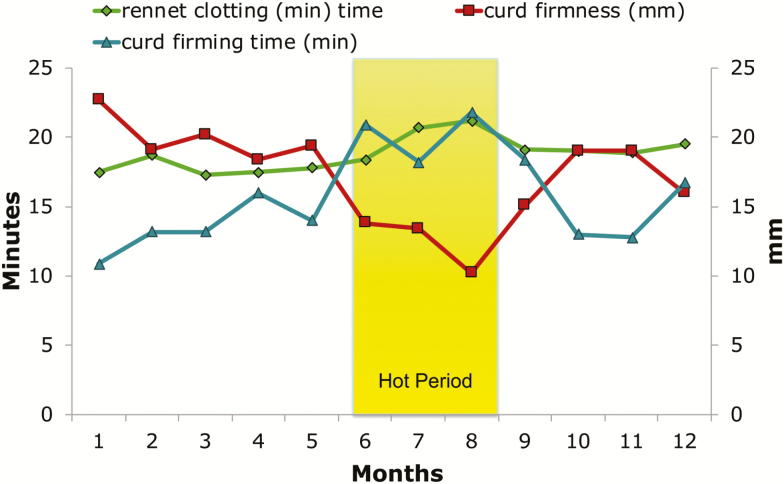
Months of production and Rennet coagulation properties of the milk (Summer et al., 1999). General significance of differences between months was P < 0.0001 for all three traits.